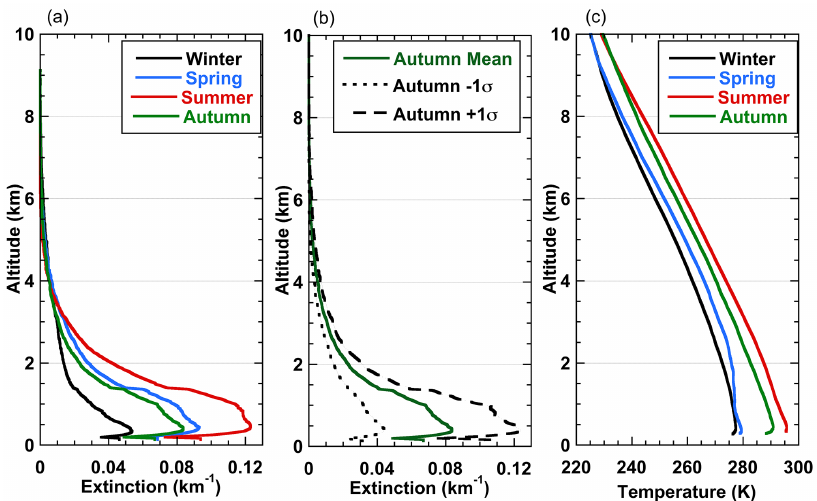
Figure 1. DOE ARM Southern Great Plains site (a) aerosol extinction coefficients as a function of altitude above ground (km) and season for non-cloudy days. Aerosol profiles were derived using multifilter rotating shadowband radiometer (MFRSR) aerosol optical depth data (Harrison et al., 1994) as input. Since these are only directly available during daytime, in order to calculate seasonal averages, nighttime values are assumed using a linear interpolation between lidar values calculated for late afternoon and the following early morning. (b) Aerosol extinction coefficient and corresponding 1 σ standard deviation for the autumn season; 1 σ standard deviations are given in broken lines. (c) Temperature profiles from the ARM Balloon-Borne Sounding System (SONDE) observations (Holdridge et al., 2011) as a function of altitude for non-cloudy days.